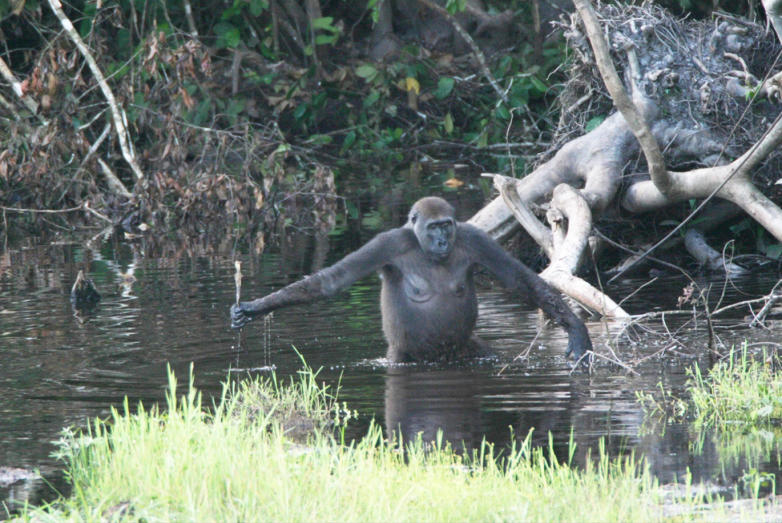
A first time for everything: This adult female gorilla in Nouabalé-Ndoki National Park, northern Congo, uses a branch as a walking stick to gauge the water's depth, proving that gorillas use tools too